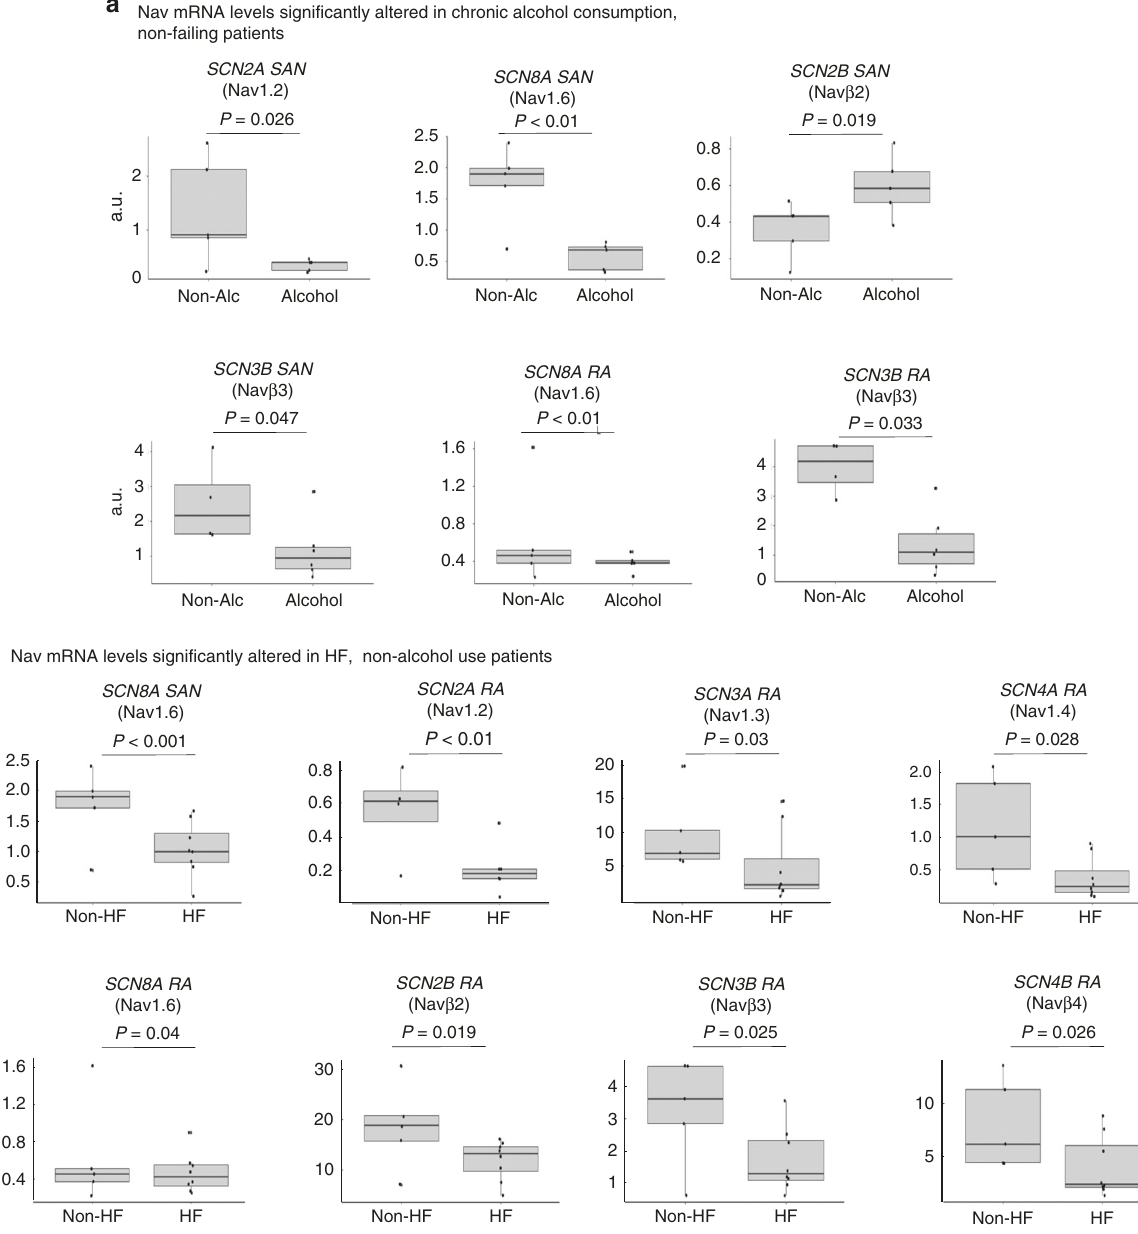
Fig. 7 Nav subunits altered in chronic alcohol users and heart failure patients. a Nav mRNA levels altered in human sinoatrial node (SAN) and right atria (RA) by chronic alcohol use in non-failing human hearts. Control n = 5, chronic alcohol use n = 5. b Nav mRNA altered in SAN and RA in heart failure (HF) non-alcohol users. Non-failing n = 5, HF n = 8. Data distributions are presented as box plots with dots as individual observations. The center line within the box represents the median, the lower and upper bounds of box represent the interquartile range, and the whiskers indicate the maximum and minimum sample values. Statistical analysis was done using mixed models in package lme4 with patient, heart weight, and indicator variables for alcohol, smoking, drug abuse, and HF. Patient was considered a random effect, others as fi xed effects. Source data are provided as a Source Data fi